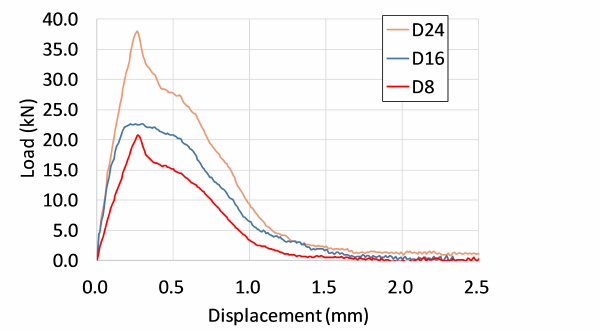
Figure 15. Load-displacement relationships with different anchor bolt diameters.